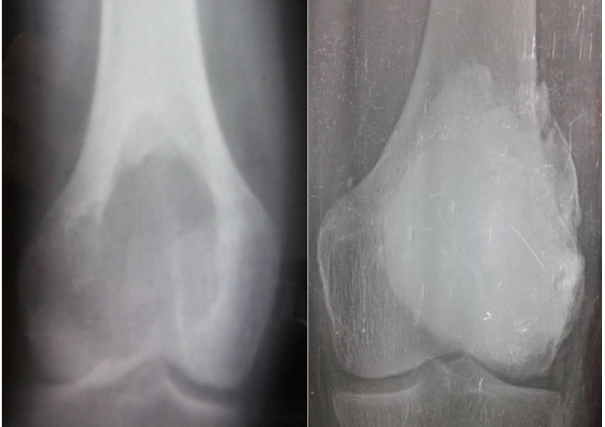
Figure 4. Serial plain radiographs (A) 18 years old patient with GCT in the distal femur (case 3), (B) 30 months last follow-up after endoscopic curettage and percutaneous bone cement application with no radiologic evidence of recurrence.